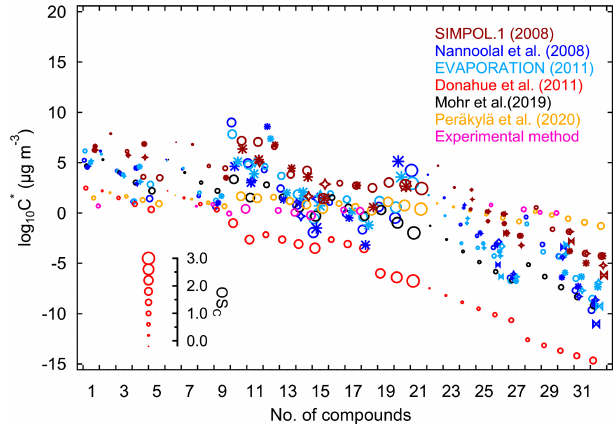
Figure 7. Saturation concentrations (in µgm − 3 , at 298.15K) of isoprene organonitrates estimated by using experimental and pa- rameterization methods. The numbers correspond with the com- pound numbers of given in Table S2 (nos. 1–9, 10–18, 19–21, 22–27, and 28–32 corresponding to 1N-monomers, 2N-monomers, 3N-monomers, 2N-dimers, and 3N-dimers, respectively). Marker shapes indicate different isomers, with their size scaled by carbon oxidation state (OS C